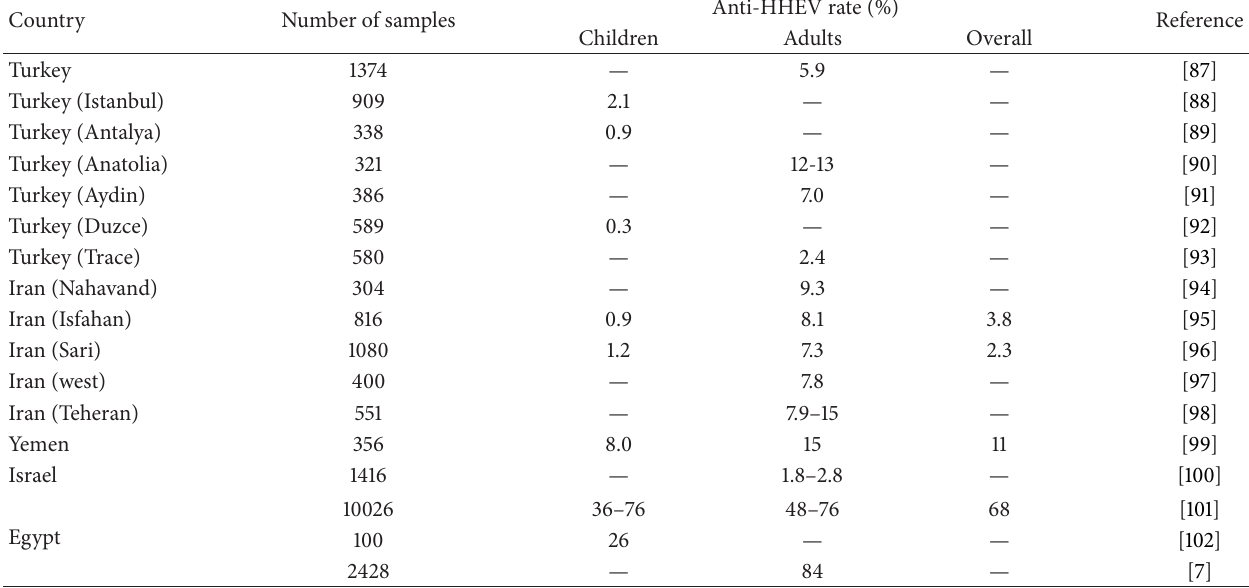
Table 3: Prevalence of anti-HHEV among the general population of the Middle East.